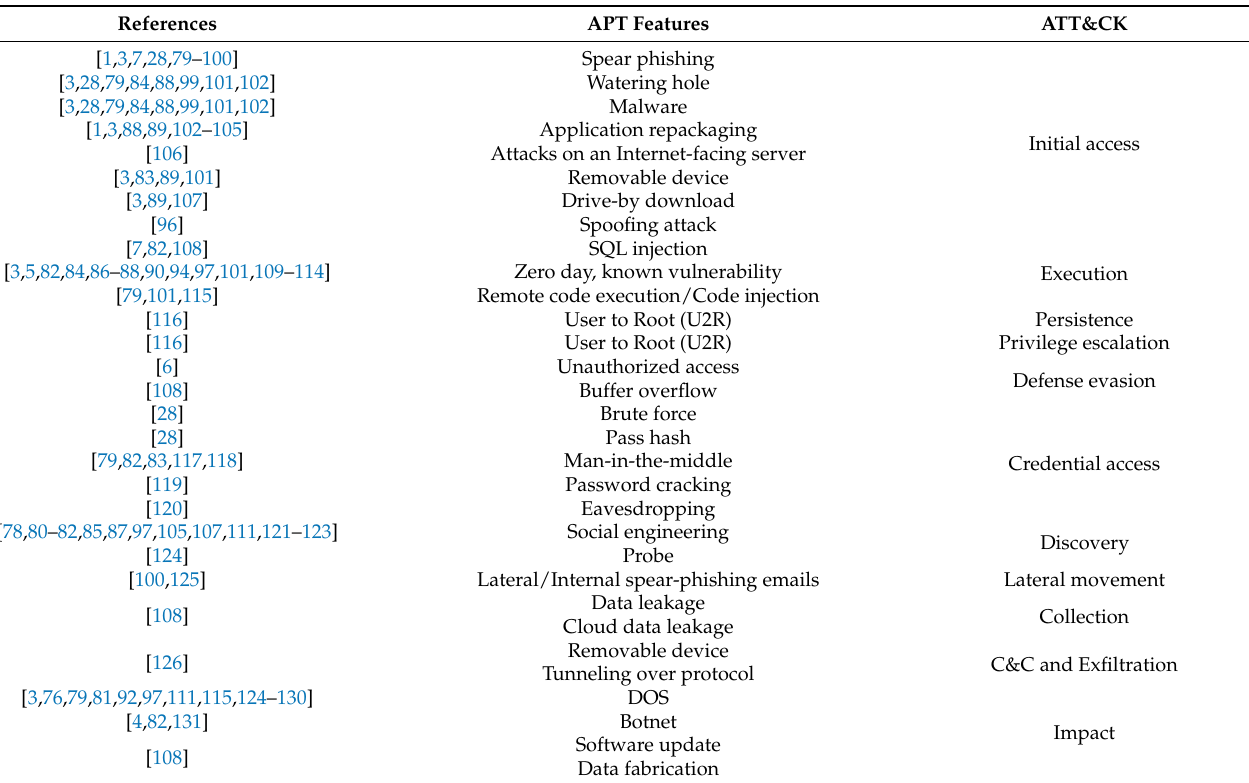
Table 4. Mapping between the collected APT features and the ATT&CK-based taxonomy: from Initial Access to Impact